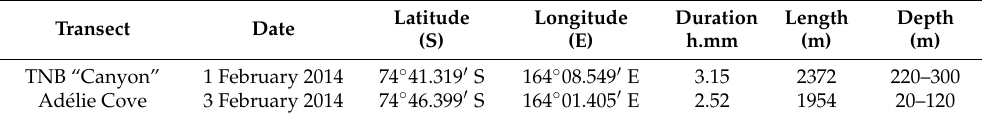
Table 1. Data of the ROV benthic survey carried out in coastal waters of Terra Nova Bay (TNB). Latitude Transect